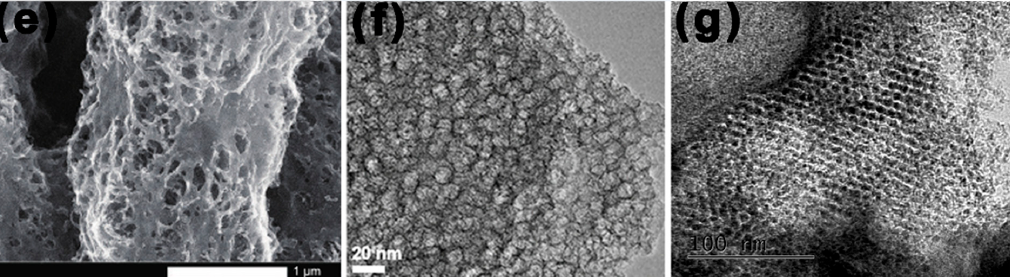
Figure 4. MCBM prepared by the hard templates method. Schematic diagram and TEM images of MCBM based on hard templates: ( a ) TEM image of CMK-2 with SBA-1 as the hard plate [68]. ( b ) TEM image of mesoporous carbon/silica nanocomposites with silica as the hard plate [64]. ( c ) TEM image of ordered mesoporous few-layer carbon with mesoporous SiO 2 as the hard plate [65]. ( d ) TEM image of a 3D cross-coupled macro–mesoporous carbon network with NaNO 3 as the hard plate [66]. ( e ) TEM image of porous nanowires-material with SiO 2 as the hard plate [67]. ( f ) TEM image of CFC@500A with Fe 3 O 4 nanoparticles as the hard plate [69]. ( g ) TEM image of N, S co-doped mesoporous carbon with SBA-15 as the hard plate